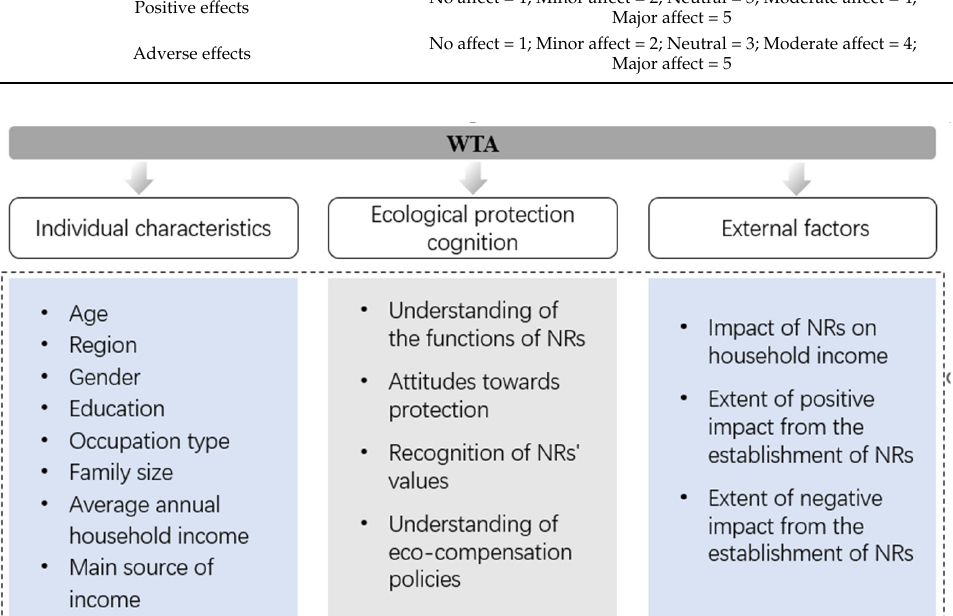
Figure 3. Framework of the research model.